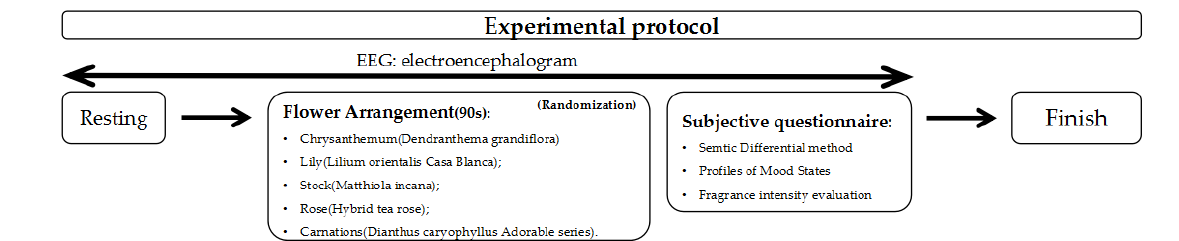
Figure 2. Experiment protocol.